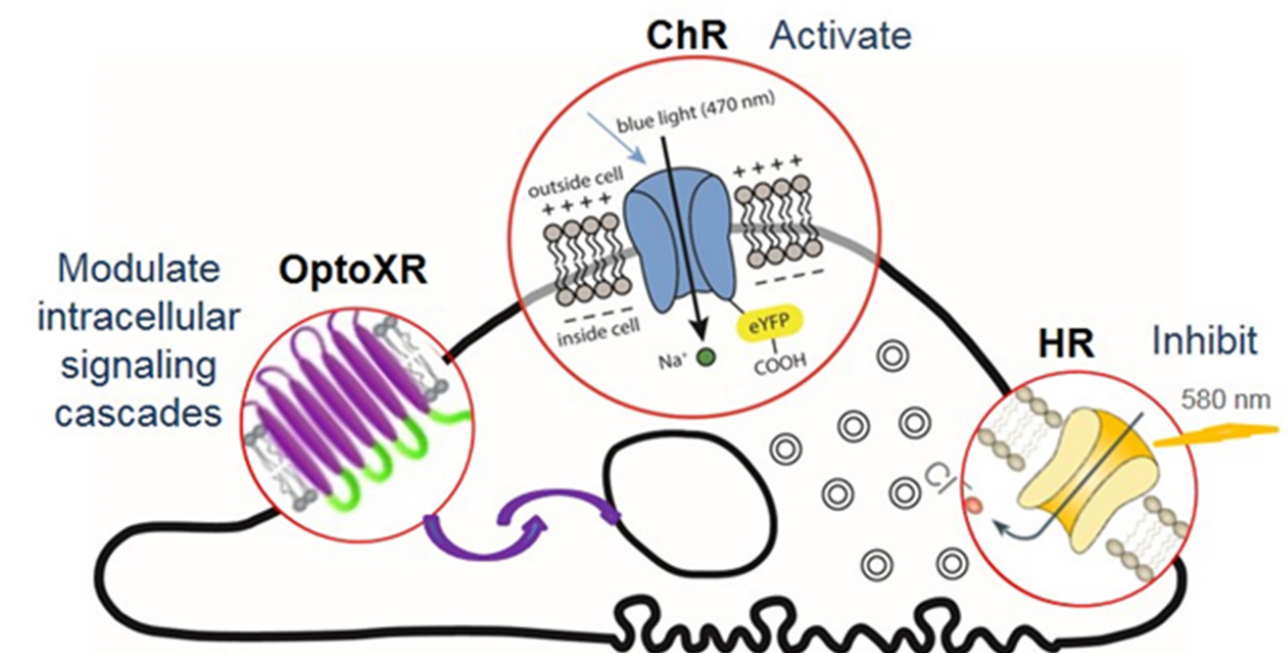
Figure 2. Common light-sensitive proteins in optogenetics research: channelrhodopsin ChR allows inward photocurrent of non-selective cations (Na + > K + >> H + >> Ca 2+ ), which can evoke cell depolarization under 470 nm wavelength light (with activating effect for excitable cells). Halorhodopsin HR, an anion (Cl − ) channel/pump, can produce membrane hyperpolarization and electrophysiological inhibition under 580 nm wavelength light. OptoXR (a G-protein-coupled receptor) is used to modulate intracellular signaling